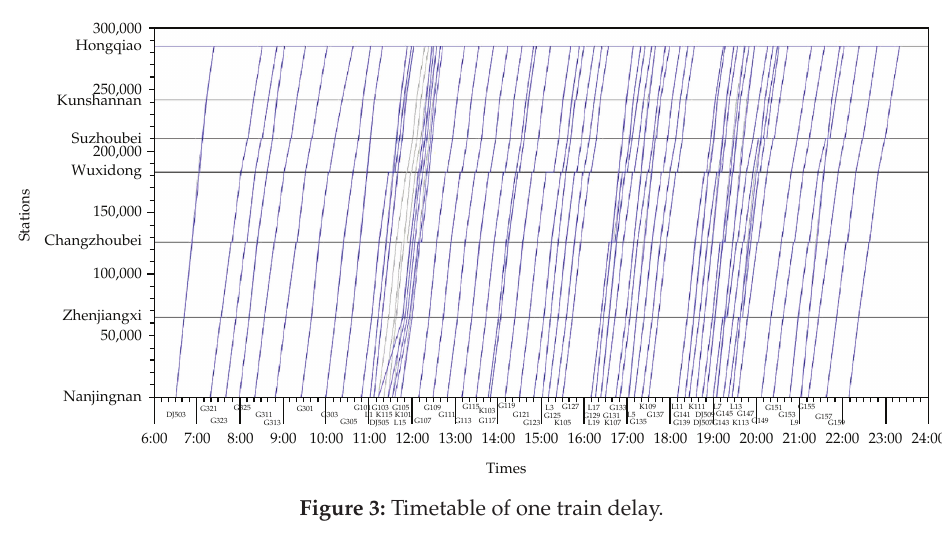
Figure 3: Timetable of one train